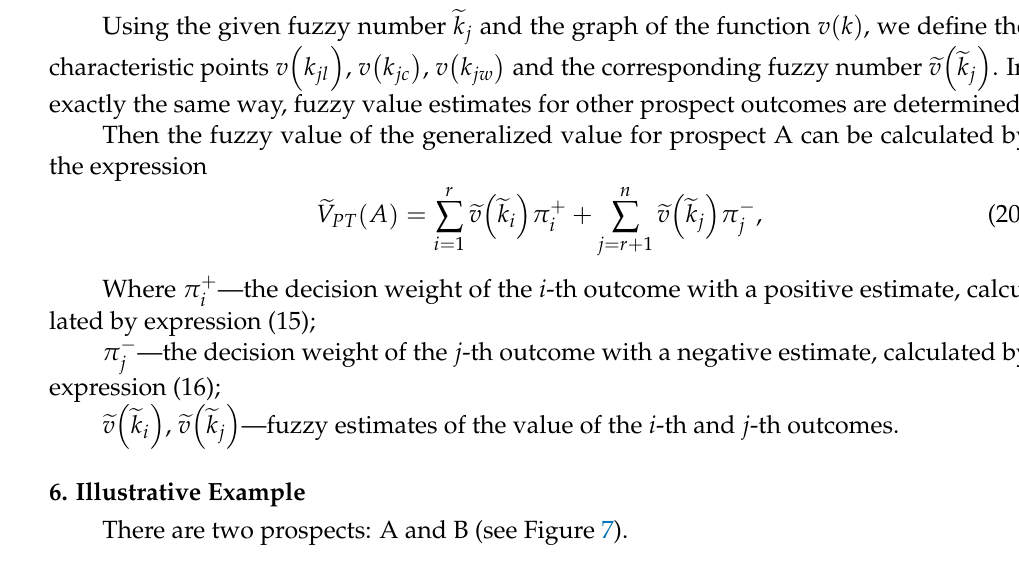
(cid:16) (cid:17) . (cid:101) k j